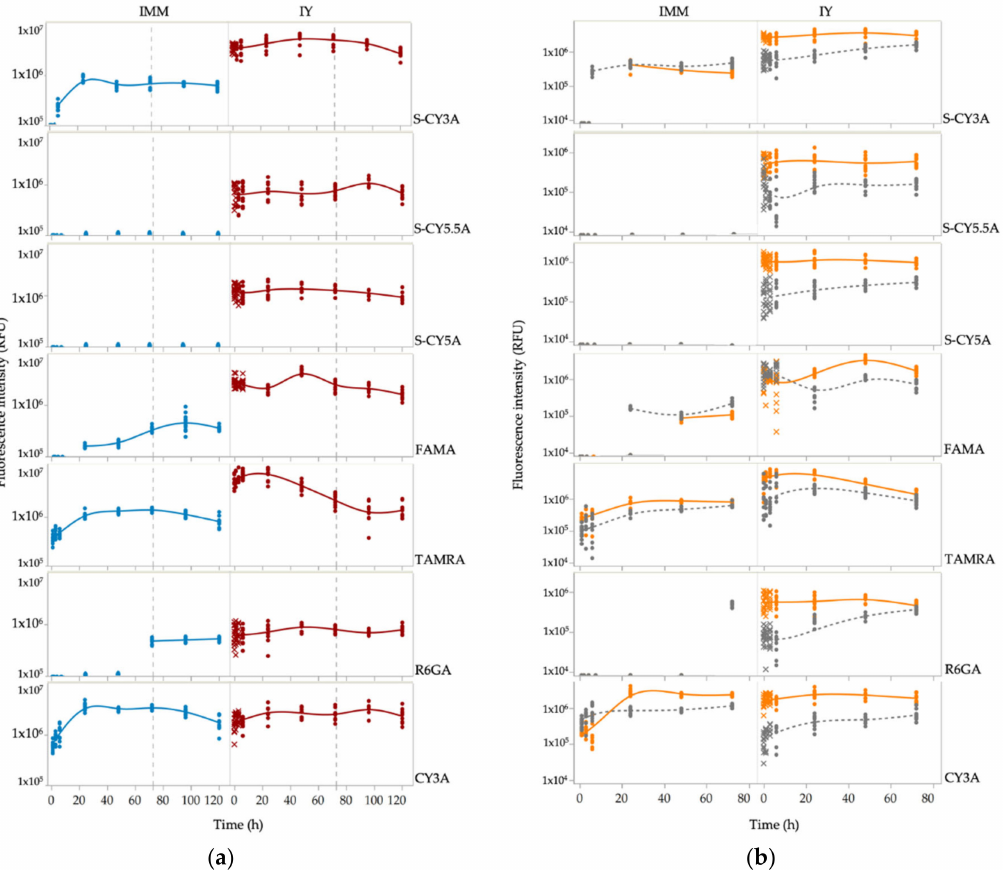
Figure 3. Semilogarithmic graphs of the fluorescence intensity (RFU) as a function of time, in the case of immersion (IMM) and intrayolk (IY) exposure routes ( a ) in the whole-body (from 0.25 to 120 h). The dashed line at 72 h indicates the start of the rinsing period. ( b ) in the yolk (orange line) and non-yolk parts (RoB, Rest of Body) (gray dash line) (from 0.25 to 72 h exposure). Excluded data points are marked as X